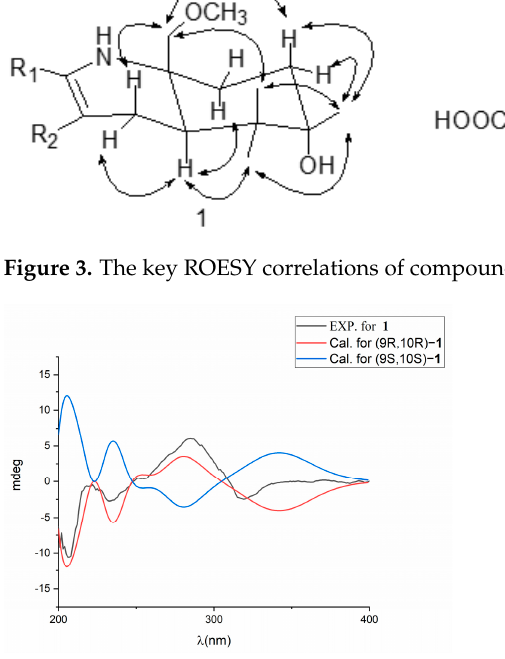
Figure 4. Comparison between the calculated and experimental ECD spectra of 1.